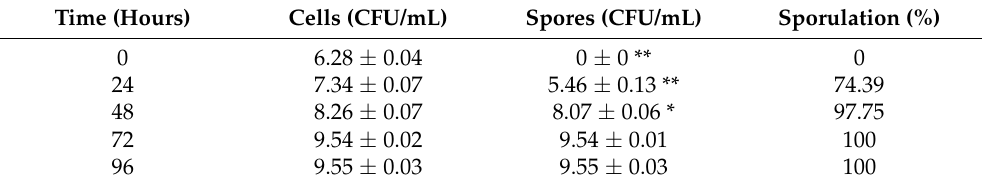
Figure 2. Antagonistic effects of Bacillus amyloliquefaciens PMB01 strain against the Rs AL03 strain of Ralstonia solanacearum on the TTC medium amended with different concentrations (0%, 0.5%, 1%, and 1.5%) of soybean meal. ( A ) Quantitative measurement of the inhibition zone (mm). ( B ) Images of the inhibition zone caused by PMB01 on the lawn of R. solanacearum . Means within the columns followed by different letters are significantly different according to Tukey’s HSD test ( p < 0.05). Table 1. Sporulation of Bacillus amyloliquefaciens PMB01 during fermentation in a 500-L tank.